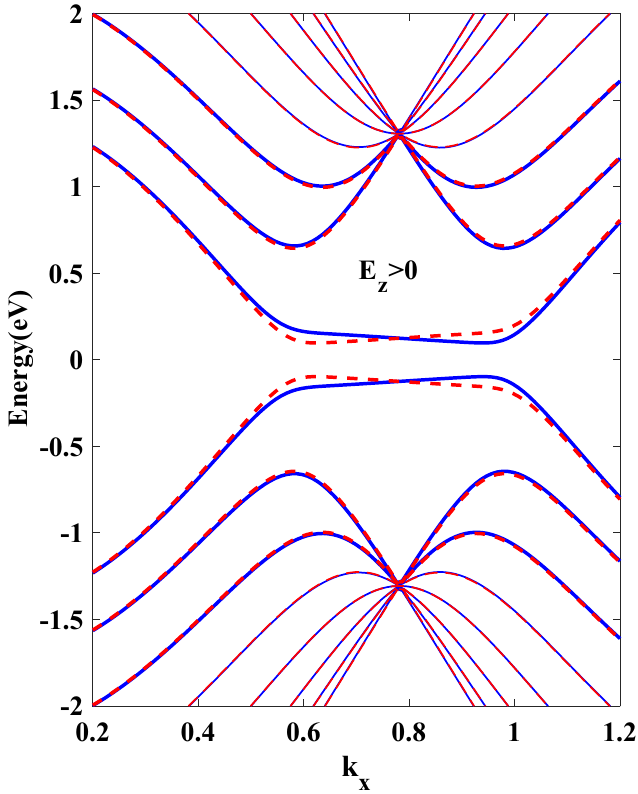
0.096 t . Blue line =